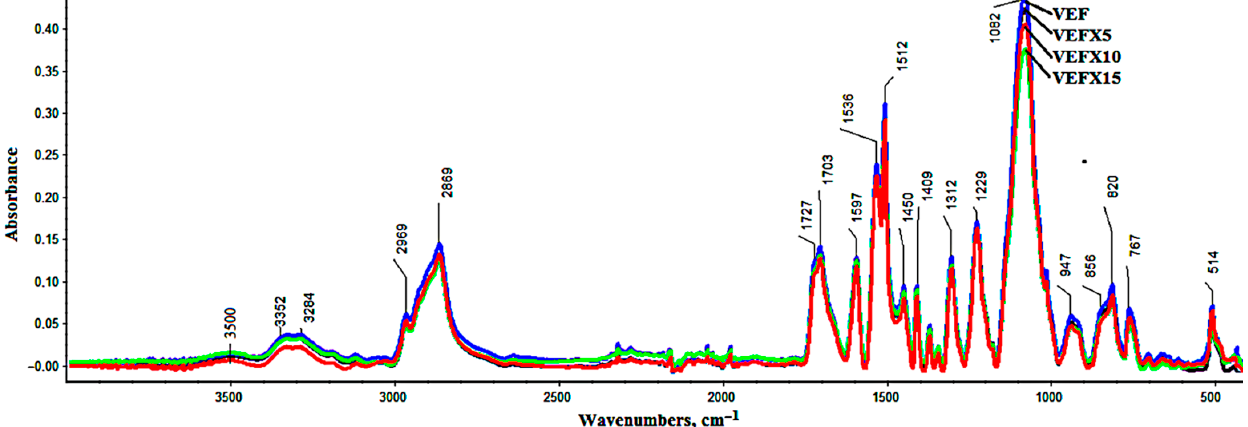
Figure 2. FT-IR spectra of unmodified foam (VEF) and modified with different content of EG 399: VEFX5, VEFX10, and VEFX15.